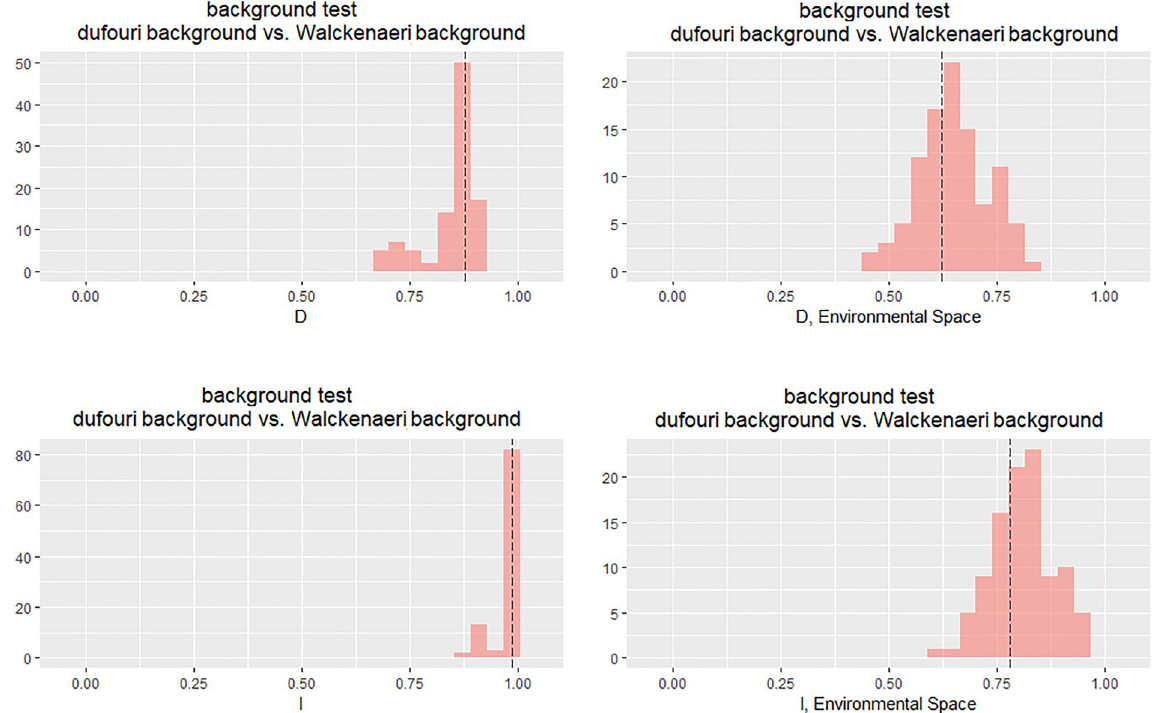
Figure 4. Results of background test for the two clades ( dufouri and walckenaeri ) across the geographical and environmental spaces . Panels show histograms of 100 simulations of background tests using two different metrics; the Schoener’s D and Warren’s I. Dotted lines indicate observed values. The figure is created using ENMTools 1.0.4 (https:// github. com/ danlw arren/ ENMTo ols).